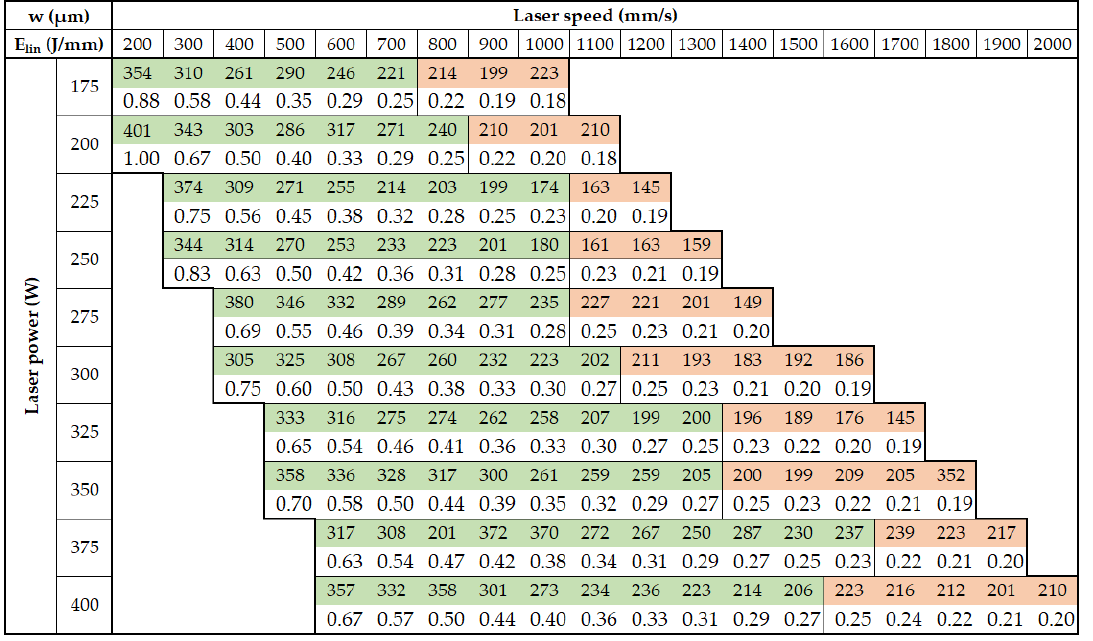
Figure 7. The average width of the single welds in and against atmosphere flow (colored cells); line energy (color free cells).